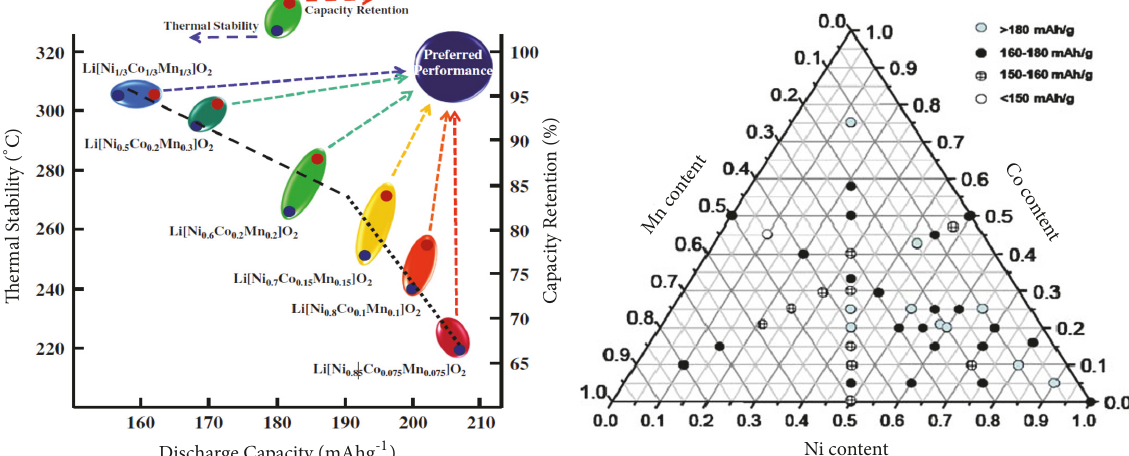
Figure 1: Elementary composition and electrochemical properties diagram of Li[Ni x Co y Mn z ]O 2 [13]. Copyright: Journal of Solid State Electrochemistry, 2009, and Journal of Power Sources, 2013.